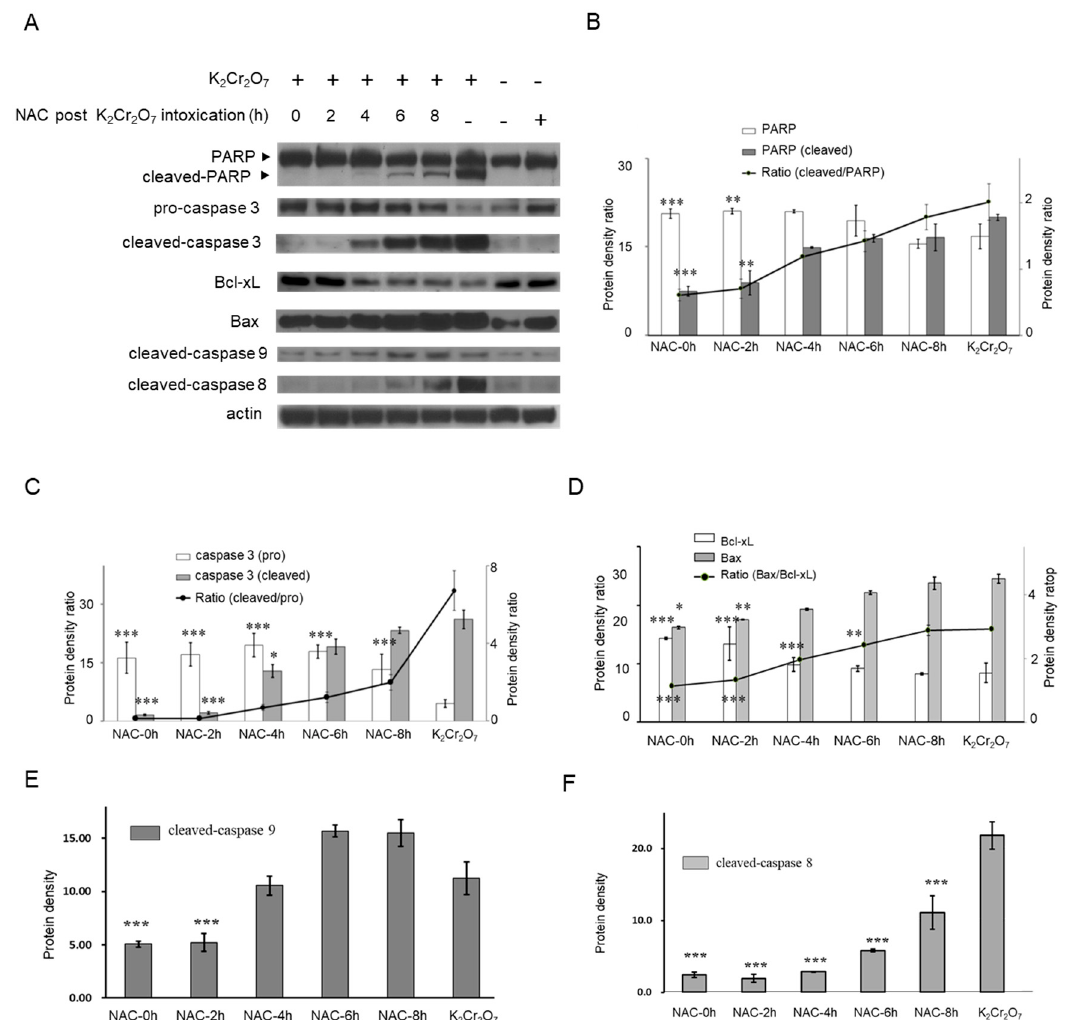
Figure 5. Evaluation of apoptosis signaling pathways. HK-2 cells were first exposed to 10 µ M K 2 Cr 2 O 7 treatment before being treated with NAC at 0, 2, 4, 6, and 8 h. Protein lysates were collected after further incubation at 36 h. ( A ) Evaluation of the protective e ff ect of NAC on K 2 Cr 2 O 7 -induced apoptosis. The levels of expression of poly (ADP-ribose) polymerase (PARP), cleaved-PARP, pro-caspase 3, cleaved-caspase 3, Bax, Bcl-xL, cleaved-caspase 9, and cleaved-caspase 8 were determined at di ff erent time-points of NAC treatment. Quantitative results of ( B ) PARP ( n = 3), ( C ) caspase 3 ( n = 3), ( D ) Bax / Bcl-xL ratio ( n = 3), ( E ) cleaved-caspase 9 ( n = 3), and ( F ) cleaved-caspase 8 ( n = 3) are